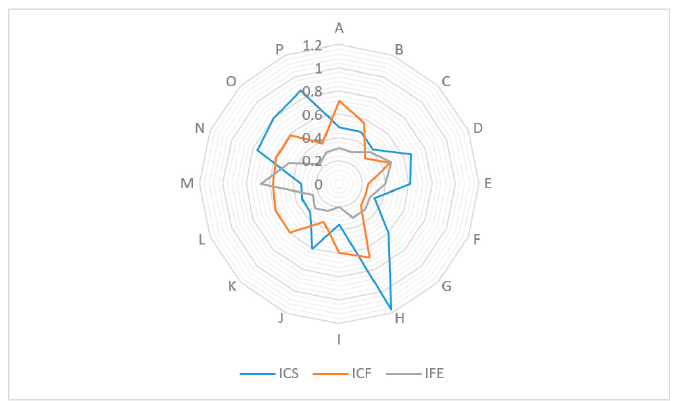
Figure 1. Integral indicators of individual components of financial support for the textile enterprises development. Source: author’s own calculations.